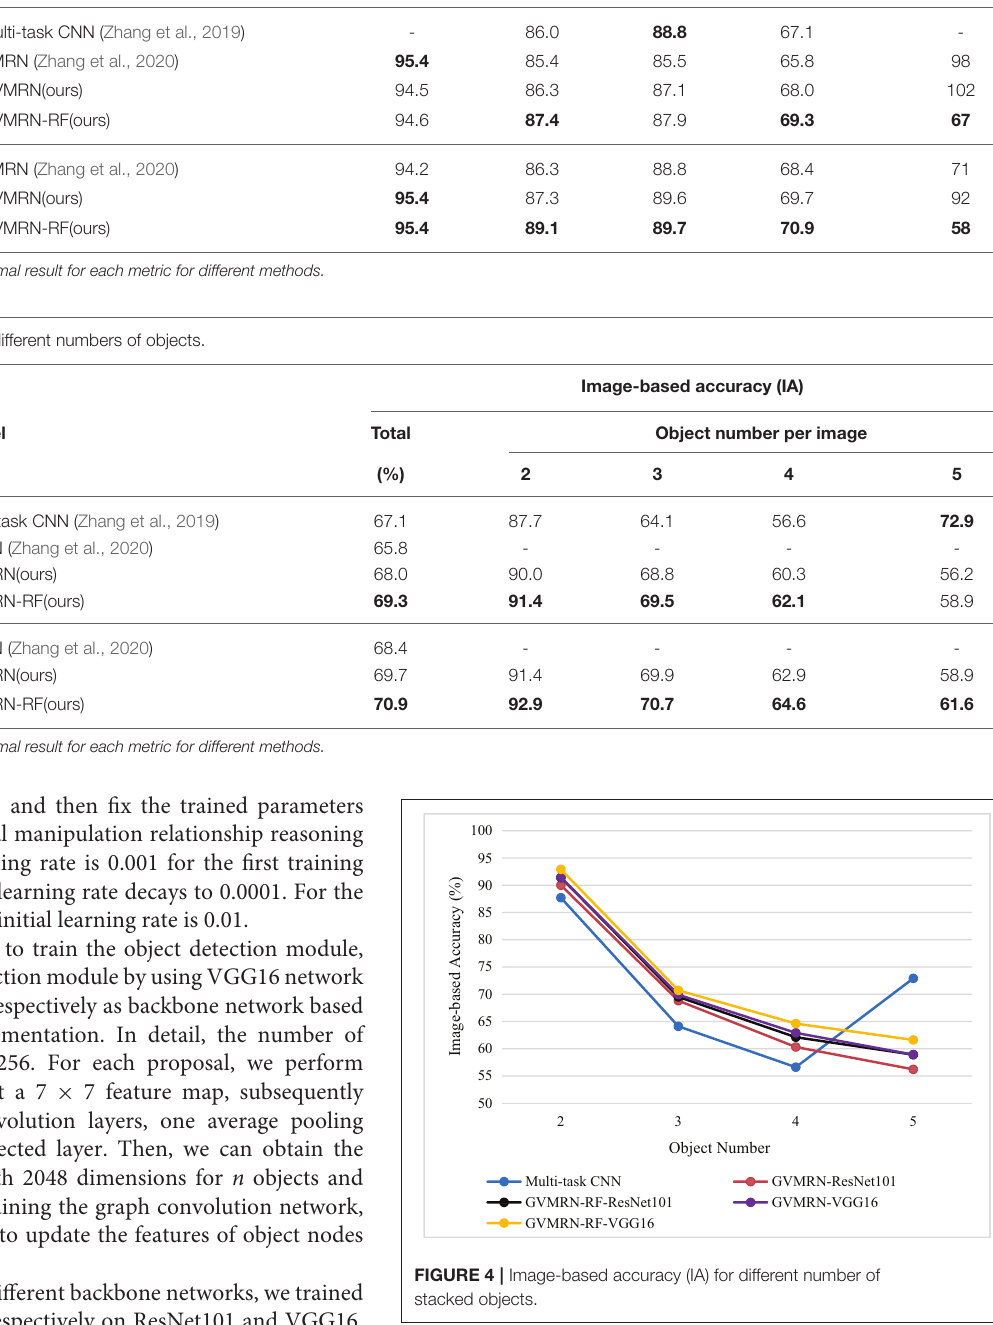
on the VMRD dataset, and 525 images are used for testing. Tables 1 , 2 show the experimental results from different aspects, and Figure 4 shows the comparison of different models by line chart. Some illustration reasoning results are given in Figure 5